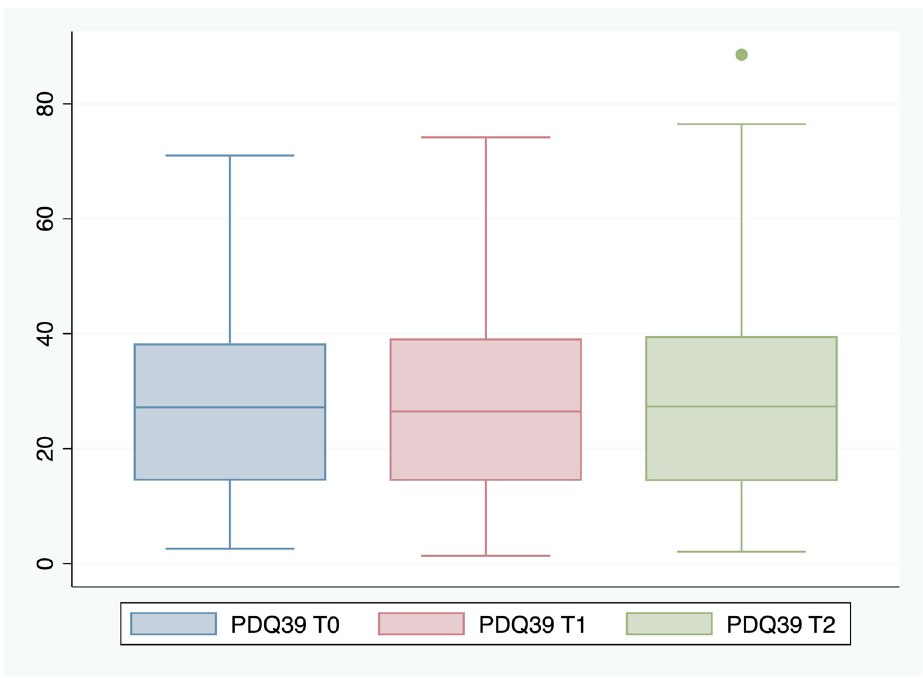
Figure 1. PDQ-39 scores at baseline (T0), 12 months (T1), and 24 months (T3).